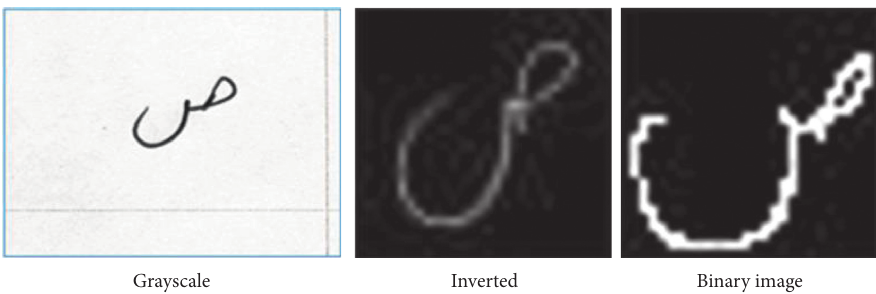
Figure 9: Conversion stages (left to right): greyscale, inverted greyscale, and